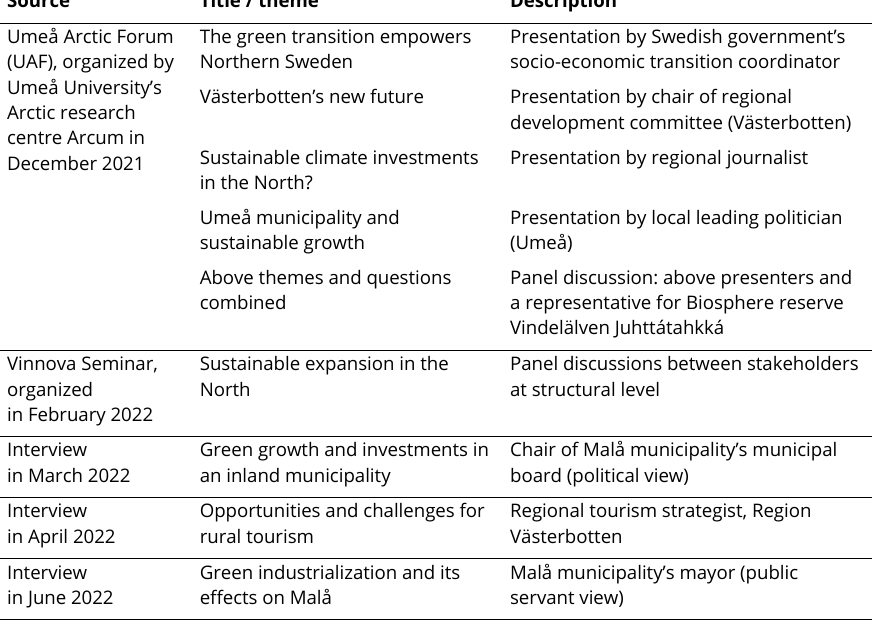
Table 1. Sources for narrative